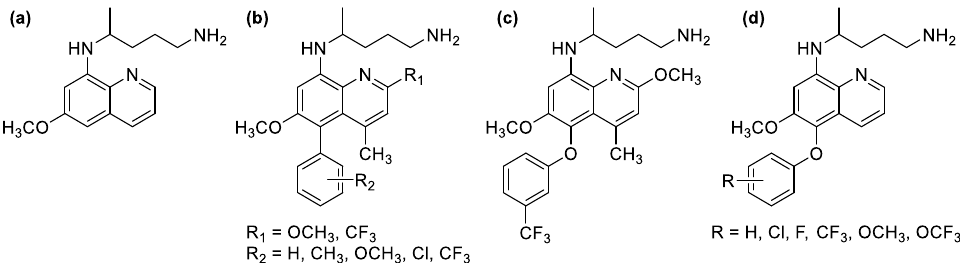
Figure 1. ( a ) Primaquine; ( b ) 5-phenyl-8-aminoquinoline derivatives; ( c ) tafenoquine; ( d ) 5-phe- noxy primaquine